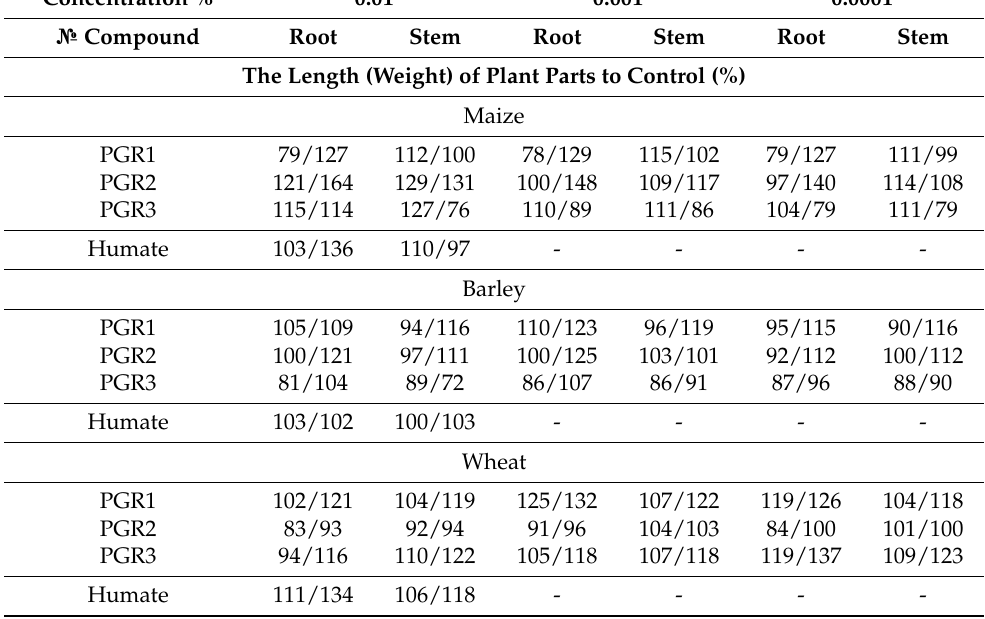
Table 1. Growth-regulating activity testing of PGR